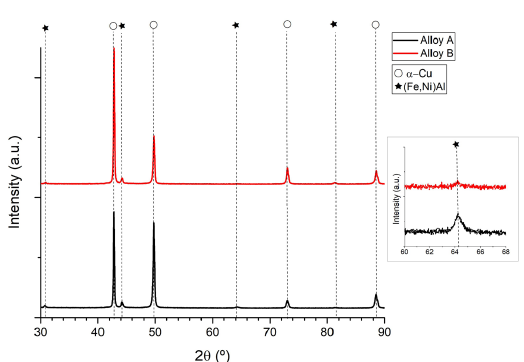
Figure 4. XRD spectra for NAB alloy A (black plot) and NAB alloy B (red plot), respectively. In the insert, a zoomed view of the peak at approx. 65º showing a peak related to K III intermetallic compounds in the Alloy A that is not as evident in Alloy B.